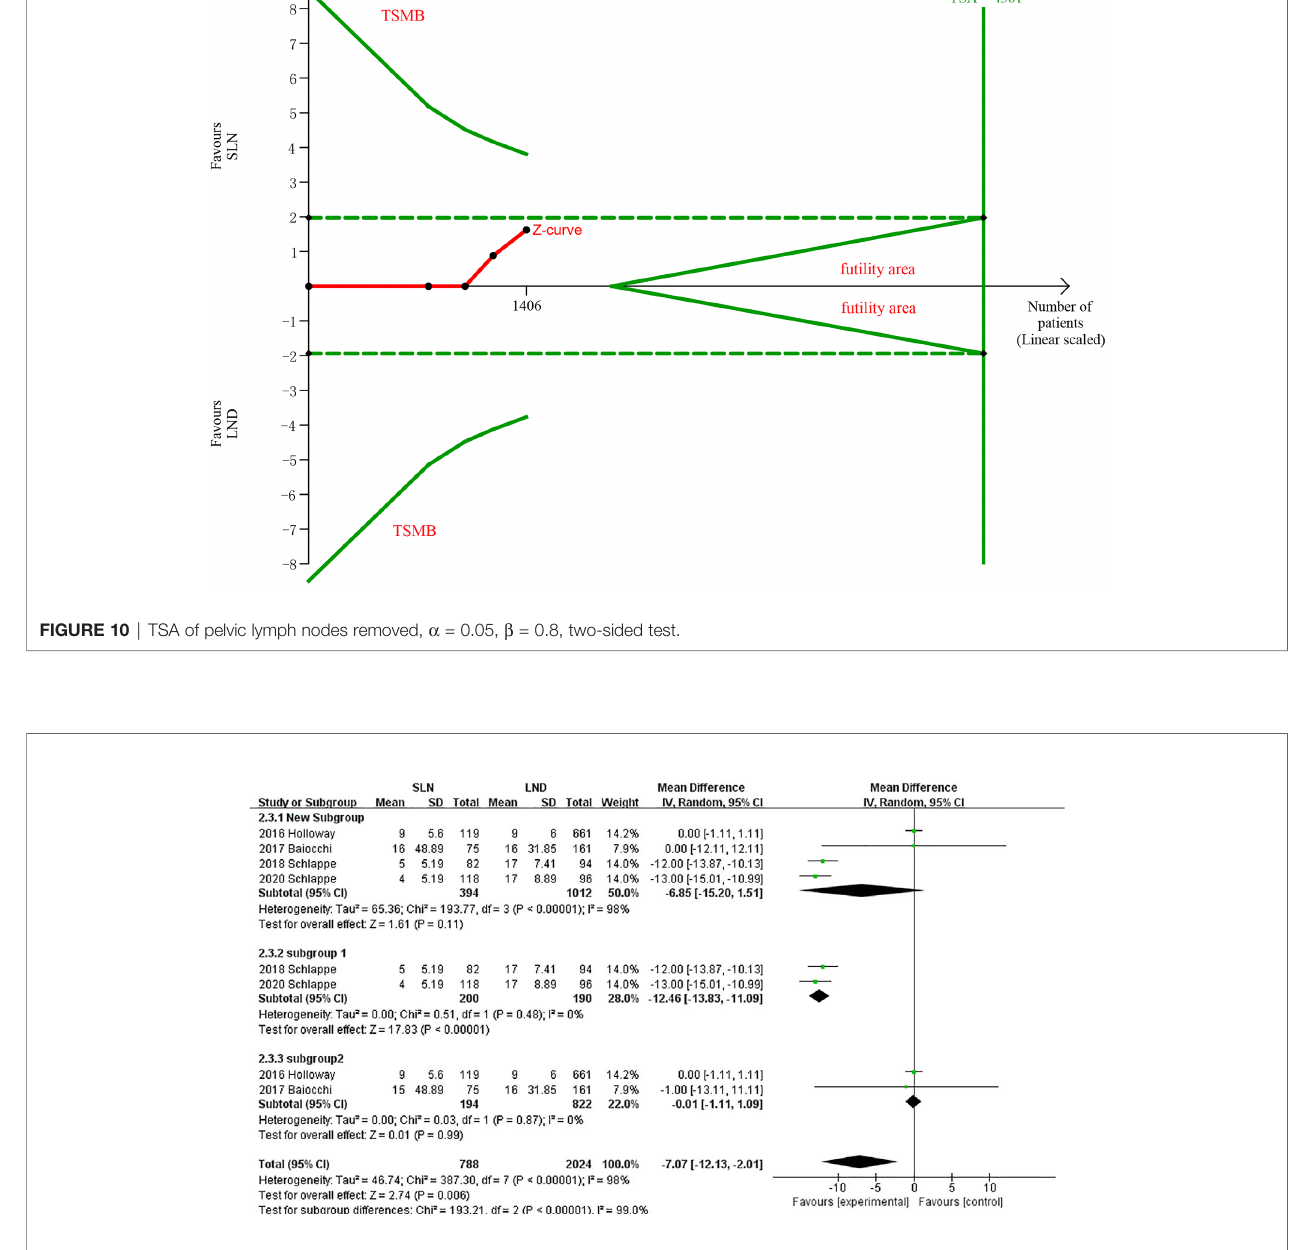
FIGURE 11 | Meta-analysis of para-aortic lymph nodes removed.